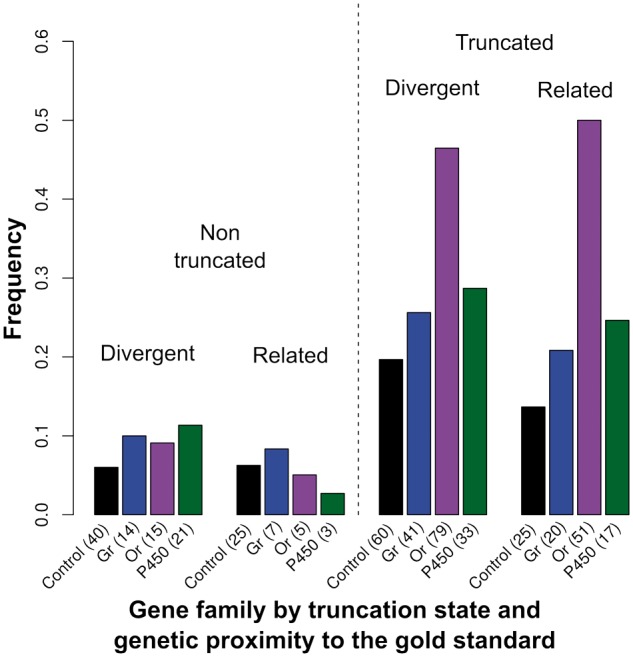
Proportion of observations with CNV per gene family, with races categorized by genetic relatedness to the gold standard. The races related to and divergent from the standard are Medicago, Pisum, Trifolium and Lathyrus, Cytisus, Ononis, Lotus pedunculatus, Lotus corniculatus, respectively (see Explanatory Variables Used in GLMM). The number of observations polymorphic for CN per category is indicated in parentheses. The total numbers of polymorphic observations were 150, 82, 150 and 74 for Control, Gr, Or and P450, respectively. These observations are distinguished between nontruncated genes (left side) and truncated genes (right side).